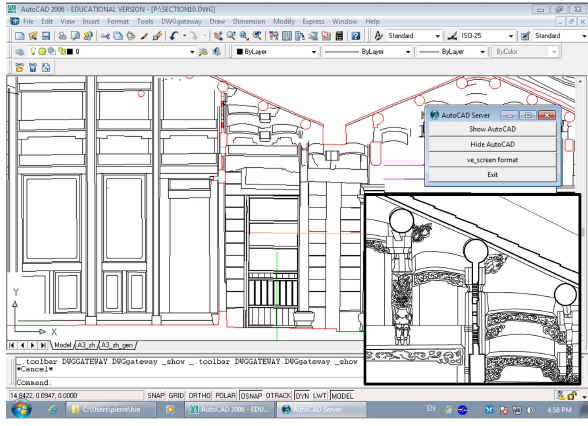
Figure 4: AutoCAD used with acad.tcl server module.